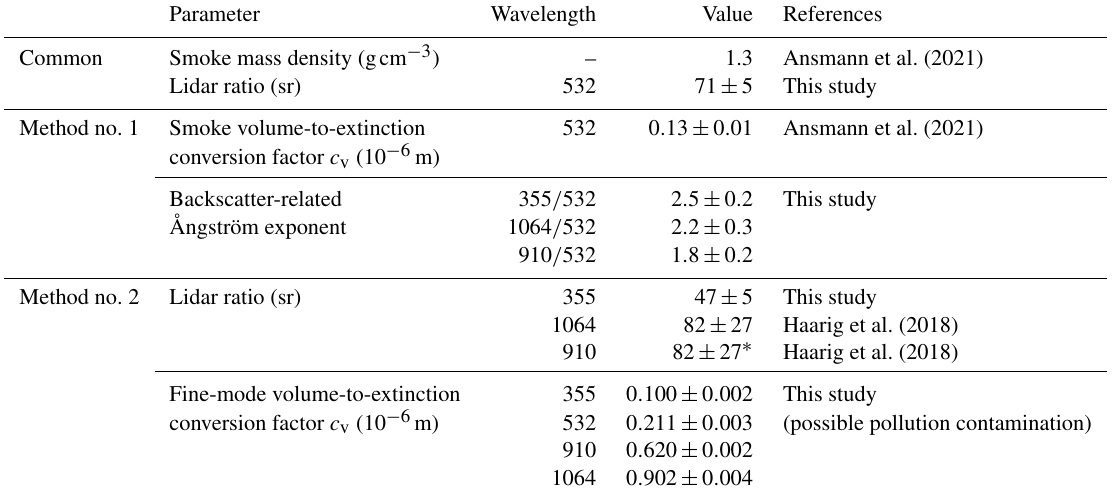
Table 2. Parameters required for the mass concentration retrieval using two methods. The smoke mass density and lidar ratio at 532nm are common parameters required for both methods no. 1 and no.